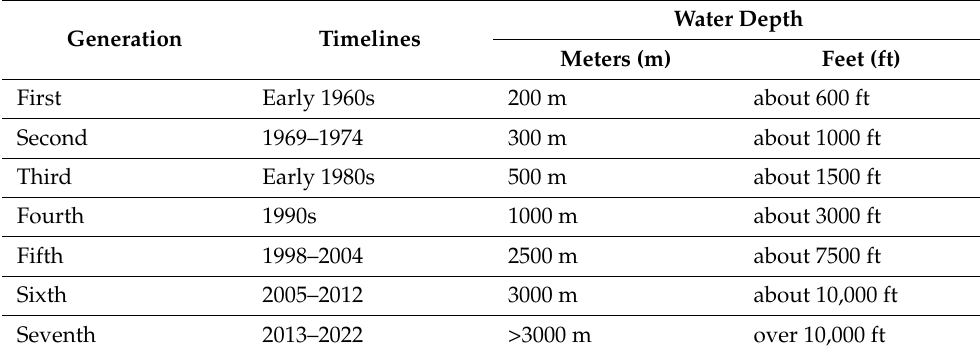
Table 4. Classification of semisubmersibles by